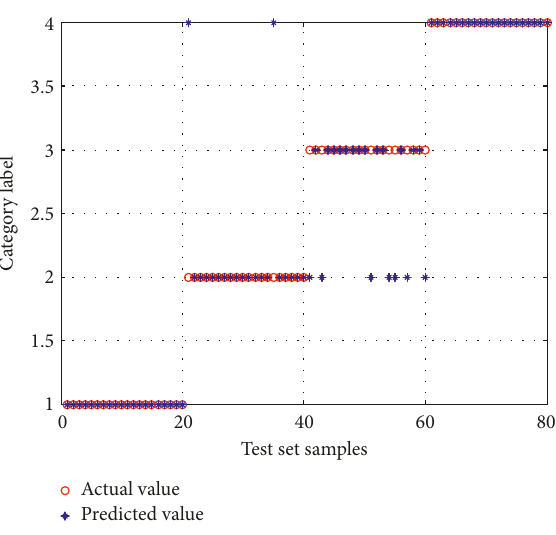
Figure 14: PSO-SVM predicted Table 4: SVM, PSO-SVM, and SFLA-SVM comprehensive comparative analysis.